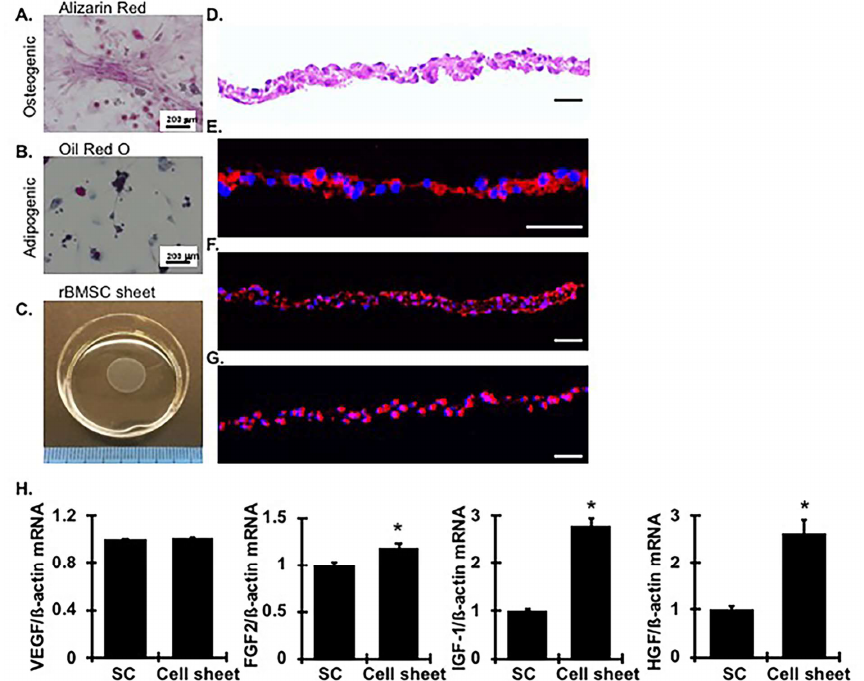
Figure 1. Characterization of rBMSC on the sheets. ( A , B ) rBMSCs obtained from SD rats were performed differentiation in adipogeneic and osteogeneic differentiation media for 3 weeks and stained with Alizarin-red ( A ) and Oil-red O ( B ), respectively. Scale bars represent 200 µ m. ( C ) rBMSC sheet was detached from the culture dish by lowering the culture temperature. ( D – G ) Representative photomicrographs of an rBMSC sheet section with hematoxylin and eosin (H&E) staining ( D ) and immunofluorescent staining for HGF (in red) ( E ), FN (in red) ( F ) and ß-catenin (in red) ( G ). DAPI (in blue) stained nuclei served as cell counterstaining of the immunofluorescent staining. Scale bars represent 50 µ m. ( H ) mRNA expression levels of VEGF, FGF2, IGF-1, and HGF in rBMSCs at the same number existed in single cell suspension (SC) or cell sheets. Measurements were carried out in triplicated dishes. * vs. SC, p < 0.05.